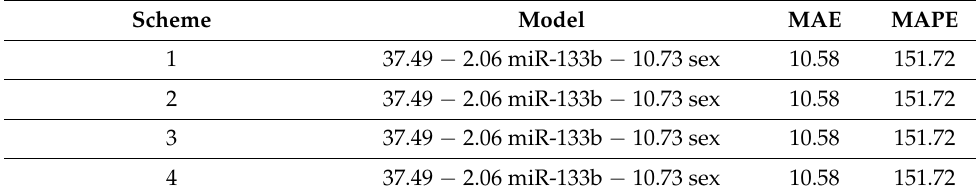
Table 6. Factor predicting AIxHR75.